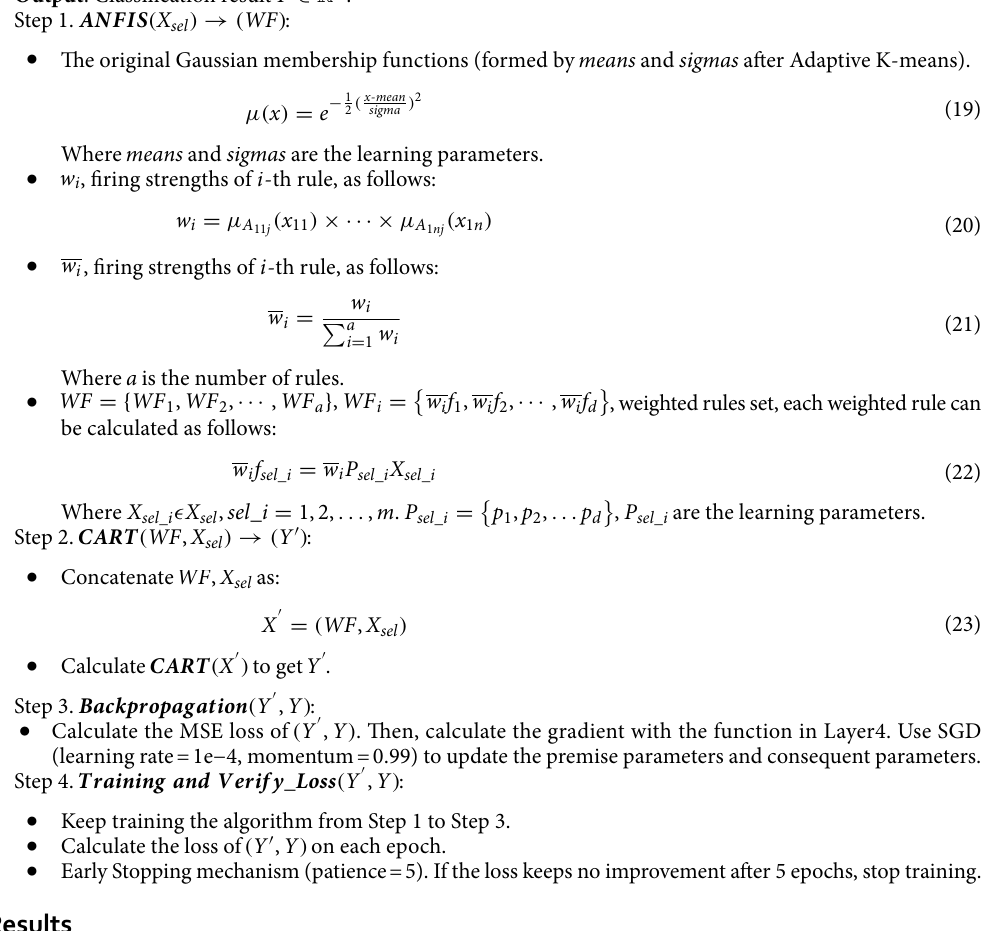
Algorithm 1 The proposed